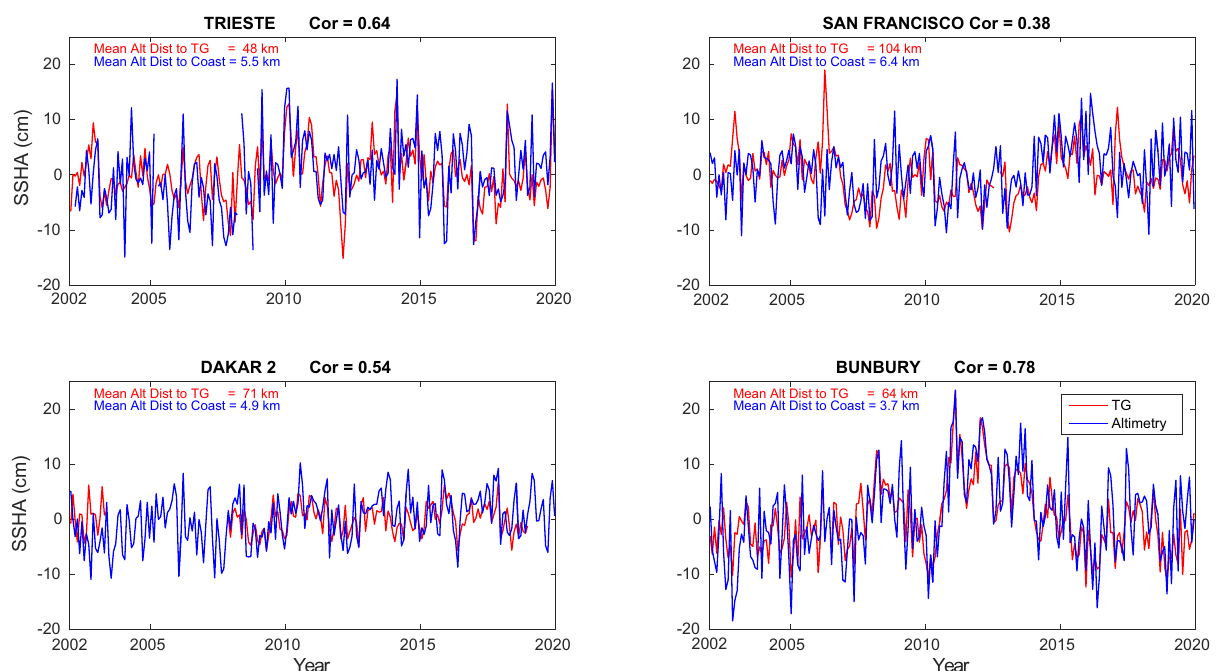
Fig. 10 Tide gauge (TG, red curve) and altimetry (Alt, blue curve) comparison at four selected sites, Trieste (Mediterranean Sea), San Francisco (North America), Dakar 2 (West Africa) and Bunbury (Australia). Each tide gauge location shows the correlation and time series between the closest averaged altimeter track and the tide gauge. The mean distance of the altimetry observations to both the tide gauge and the coast is also shown. SSHA means sea surface height